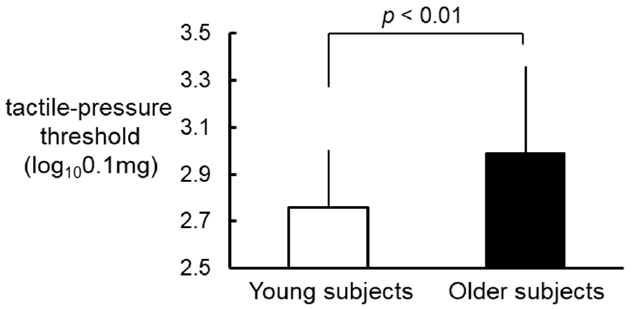
Figure 1. Comparison of the tactile-pressure threshold between young (open bar) and older (closed bar) subjects. Values are shown as the mean ± standard deviation.